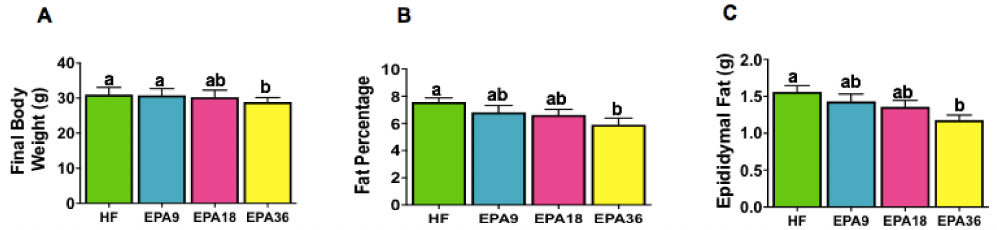
Figure 2. Dose-dependent e ff ects of EPA on final body weight, fat percentage, and epididymal fat pad weight in mice. ( A ) EPA36 significantly reduced body weight compared to HF, ( B ) EPA36 significantly reduced fat percentage compared to HF. ( C ) EPA36 significantly reduced epididymal fat pad weight compared to HF. Data are expressed as mean ± SEM. Groups represented with same letter indicate no di ff erence. p < 0.05; n = 15 mice per group. EPA, eicosapentaenoic acid; HF, high